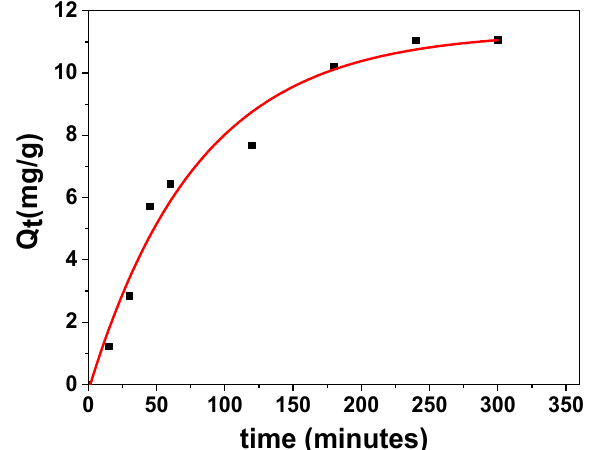
Figure 3. Adsorption kinetic curve of ST-HEMA-GMA-BCD-NH 2 at pH 5 and 25 °C.